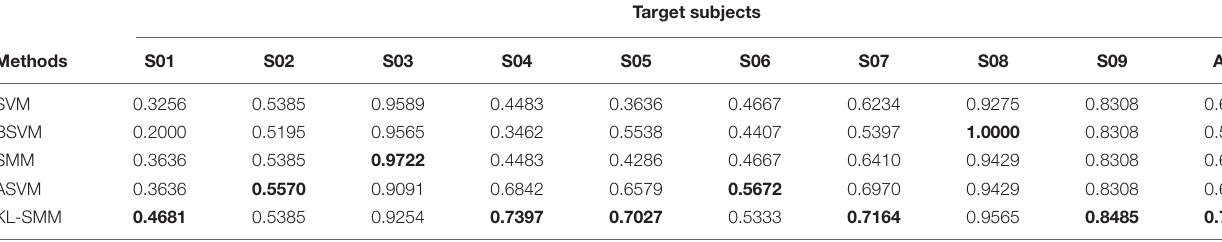
TABLE 4 | Comparison of ACC using 14 labeled target EEG data in Exp. 2 .